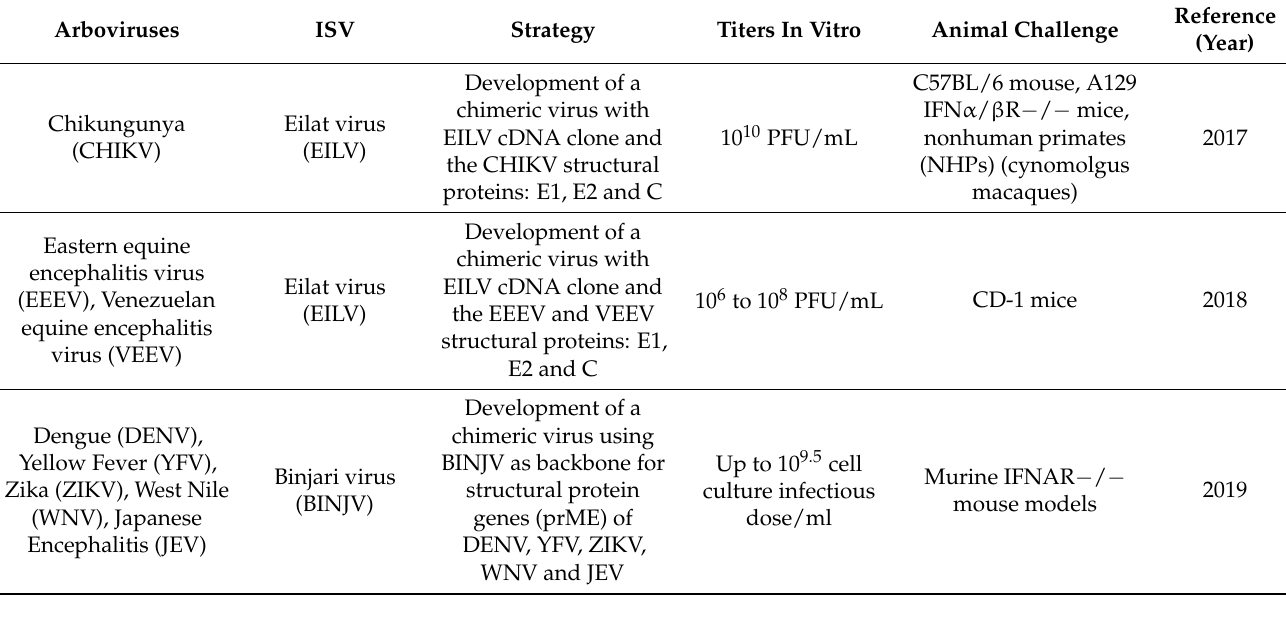
Table 1. Insect-specific virus-based vaccines developed against arboviruses.